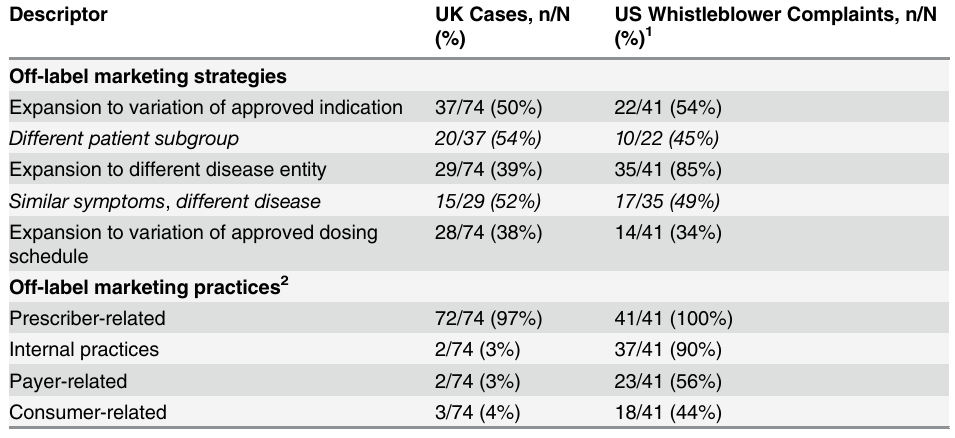
Table 2. Frequency of off-label marketing strategies and practices reported in PMCPA rulings (2003 – 2012) and US whistleblower complaints (1996 –